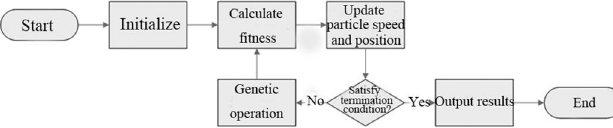
Fig. 4. The calculation fl ow of the improved